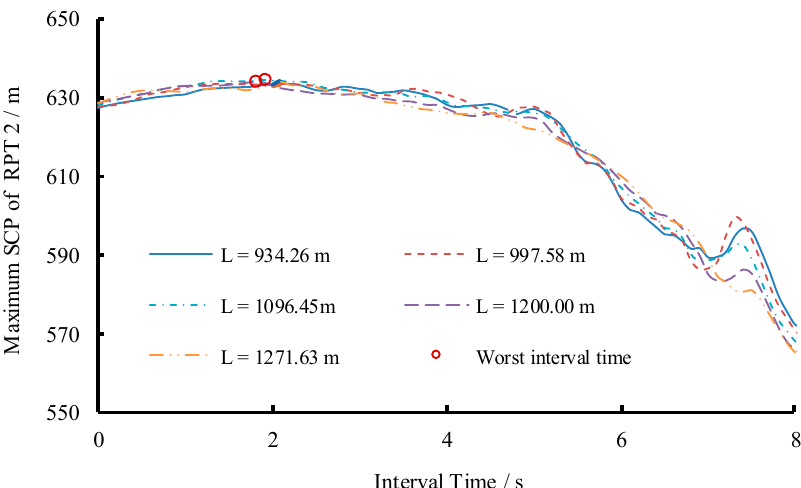
ff erent time intervals for each scheme of Scenario 3. Energies 2019 , 12 , x FOR PEER REVIEW